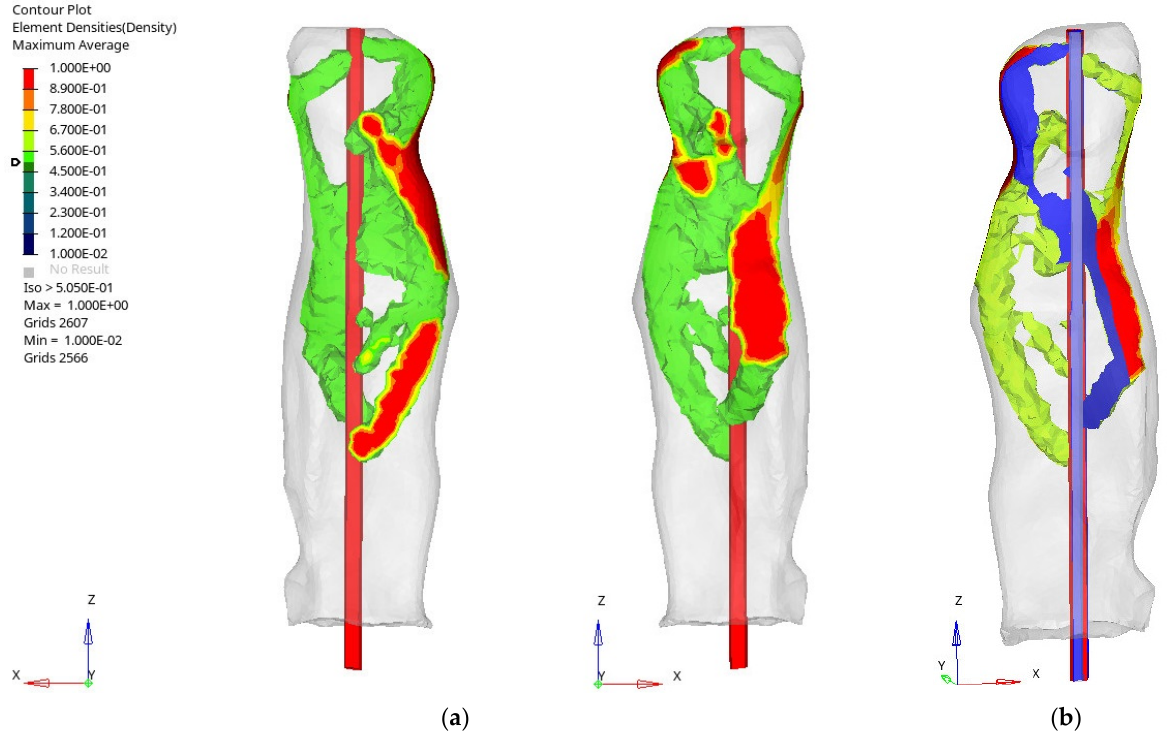
Figure 6. CB_Sa case: density distribution ( a ) Back and front View) ( b ) Two intersecting sectional views (in blue).